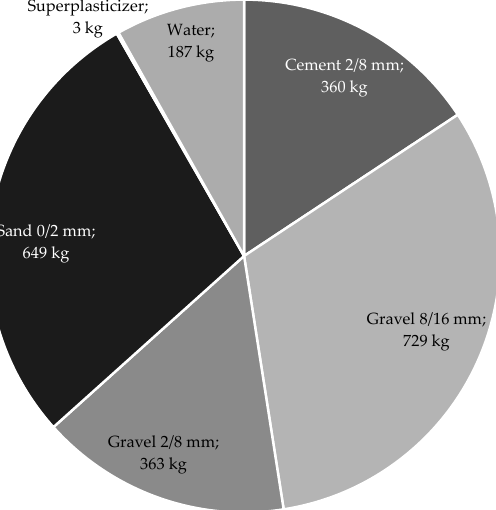
Figure 4. Concrete materials in kg (according to [79]).